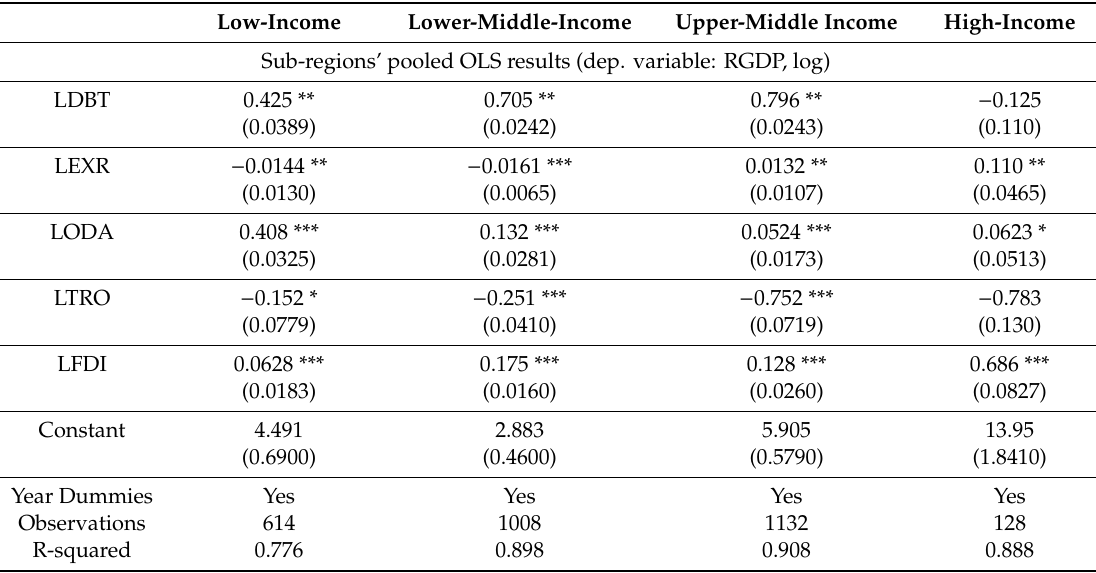
Table 5. Pooled OLS for comparative analysis across the four World Bank income